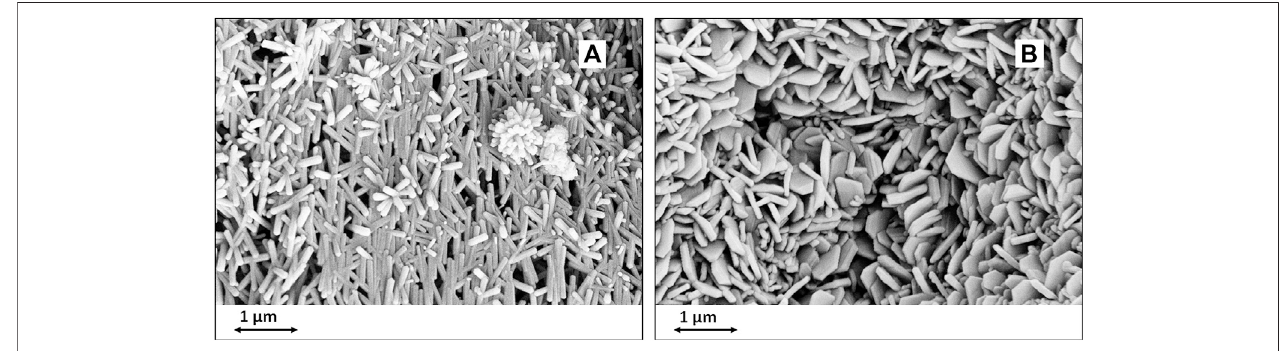
FIGURE 4 | SEM images of nanostructured biomorphic scaffolds as obtained by different hydrothermal conditions. (A) : neutral pH; (B) : alkaline pH.